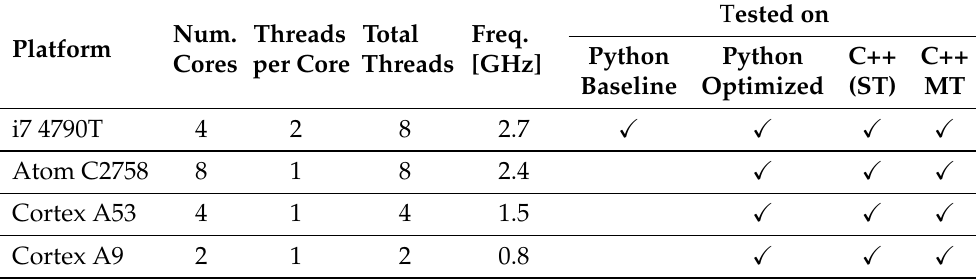
Table 5. Configurations of different platforms for software based